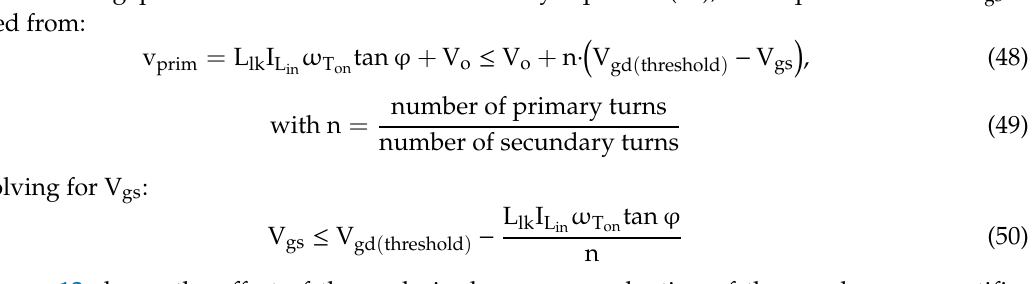
Figure 12. Effect of the undesired reverse conduction of the synchronous rectifier transistors at the end of the gap state (inside the circles).